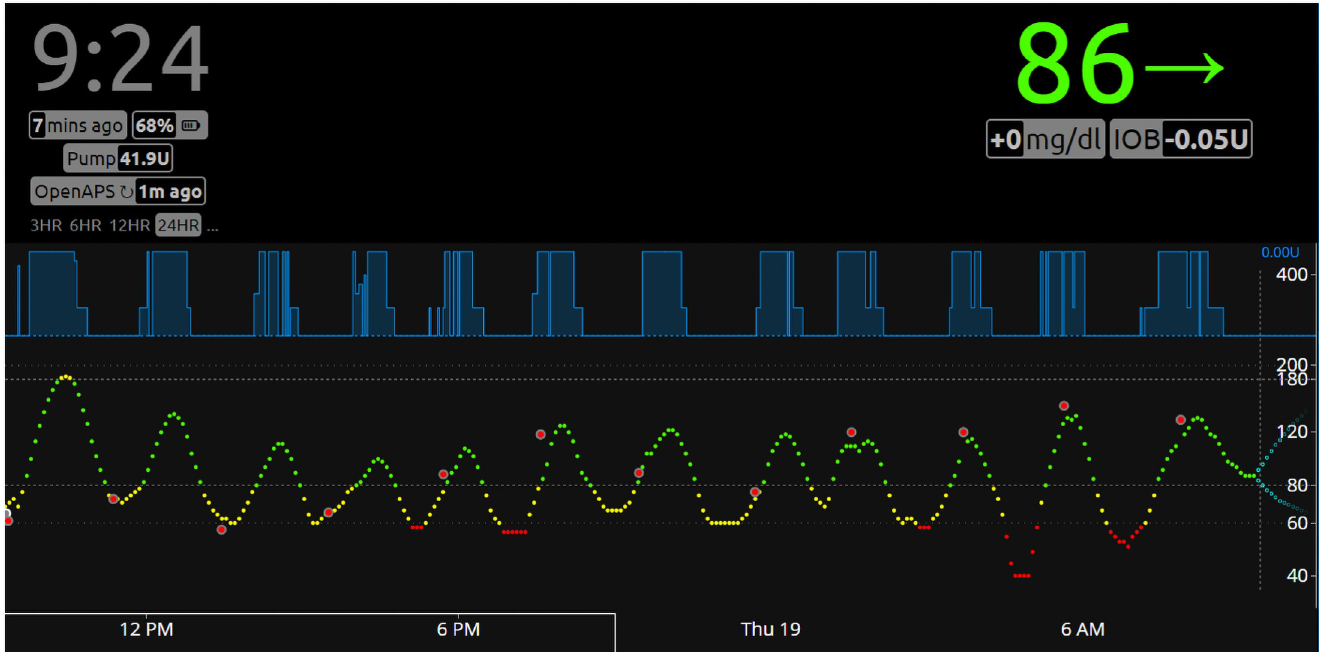
Fig 2. BGL and insulin infusion rate of a diabetic rat controlled by OpenAPS. A representative Nightscout image is shown with color-coded BGL including normal (green), moderate hypoglycemia (yellow), and severe hypoglycemia (red). The blue shaded boxes show basal insulin infusion rate controlled by OpenAPS. The big red circles represent BG readings determined by Contour Next glucose meter, which were used to calibrate the sensor. Other pertinent information such as current BG (86 in green), the trend of BG (horizontal arrow in green), the current time (9:24), sensor reading (7 min ago), and OpenAPS looping (1 min ago), etc. are also shown. The image shows a representative of 7 different experiments using two different diabetic